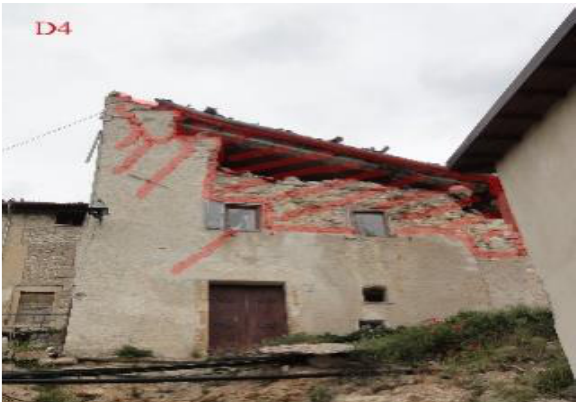
Figure 6. Structural Unite #165. Damage class D4 is assigned (EMS98).